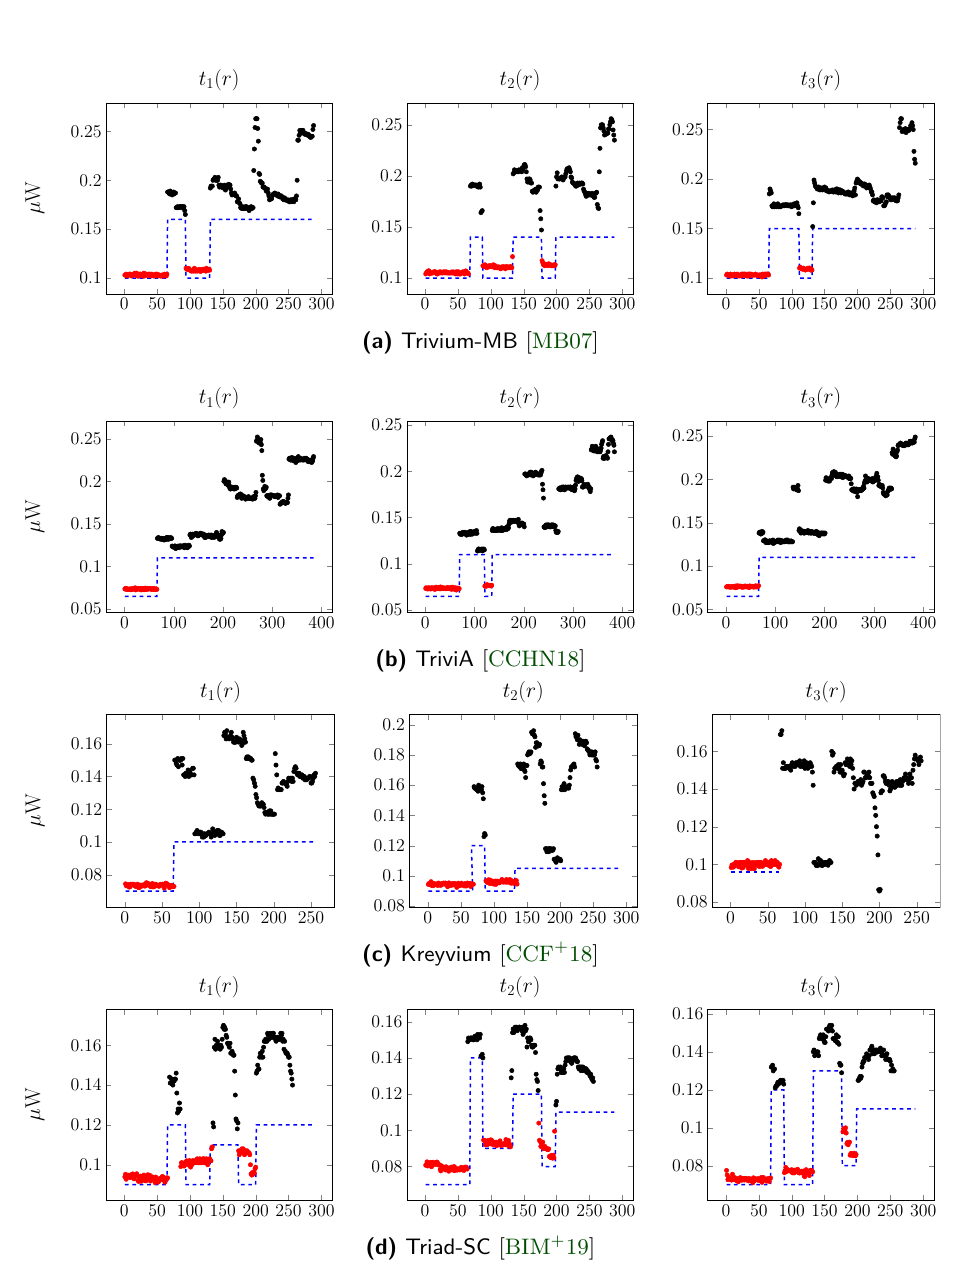
Figure 14: Power consumption measurements for all the unrolled strand trees for the 128-bit key size variation of Trivium proposed by Maximov and Biryukov [MB07], the state update function of the TriviA stream cipher [CCHN18], Kreyvium [CCF + 18] and Triad-SC [BIM + 19]. The Measurements were obtained using the TSMC 90 nm process at a frequency of 10